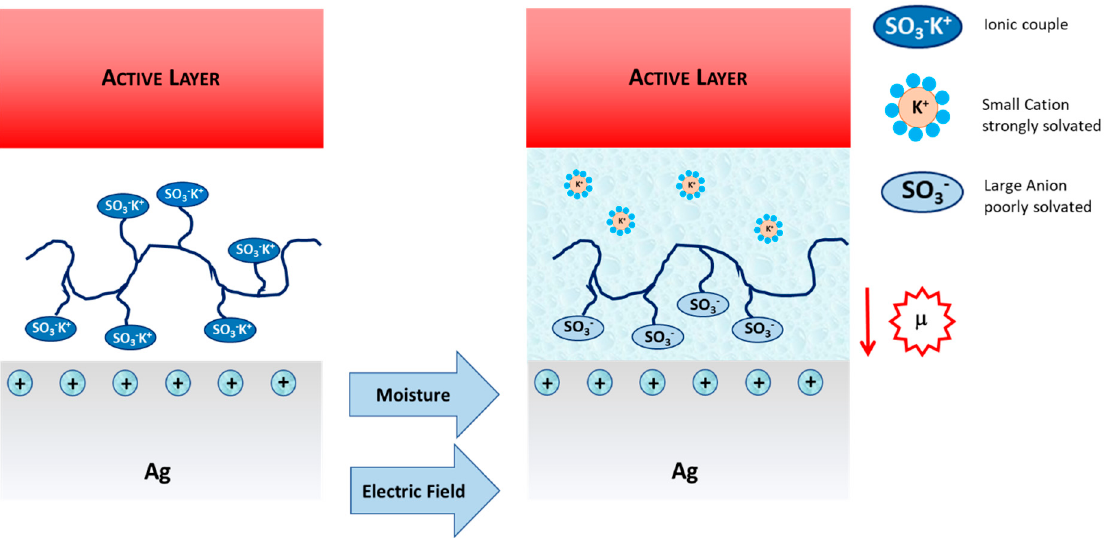
Figure 8. Proposed mechanism for moisture annealing.